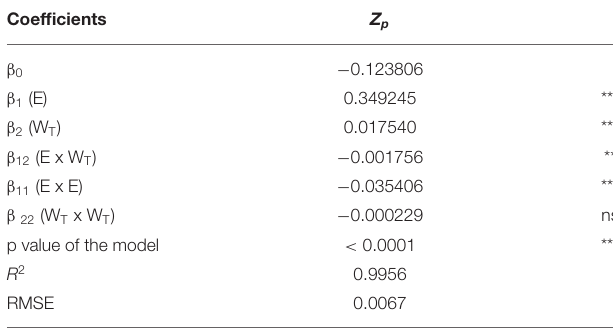
TABLE 2 | Analysis of variance (ANOVA) of the second polynomial model for the cell disintegration index ( Z p ) of PEF treated grape pomace